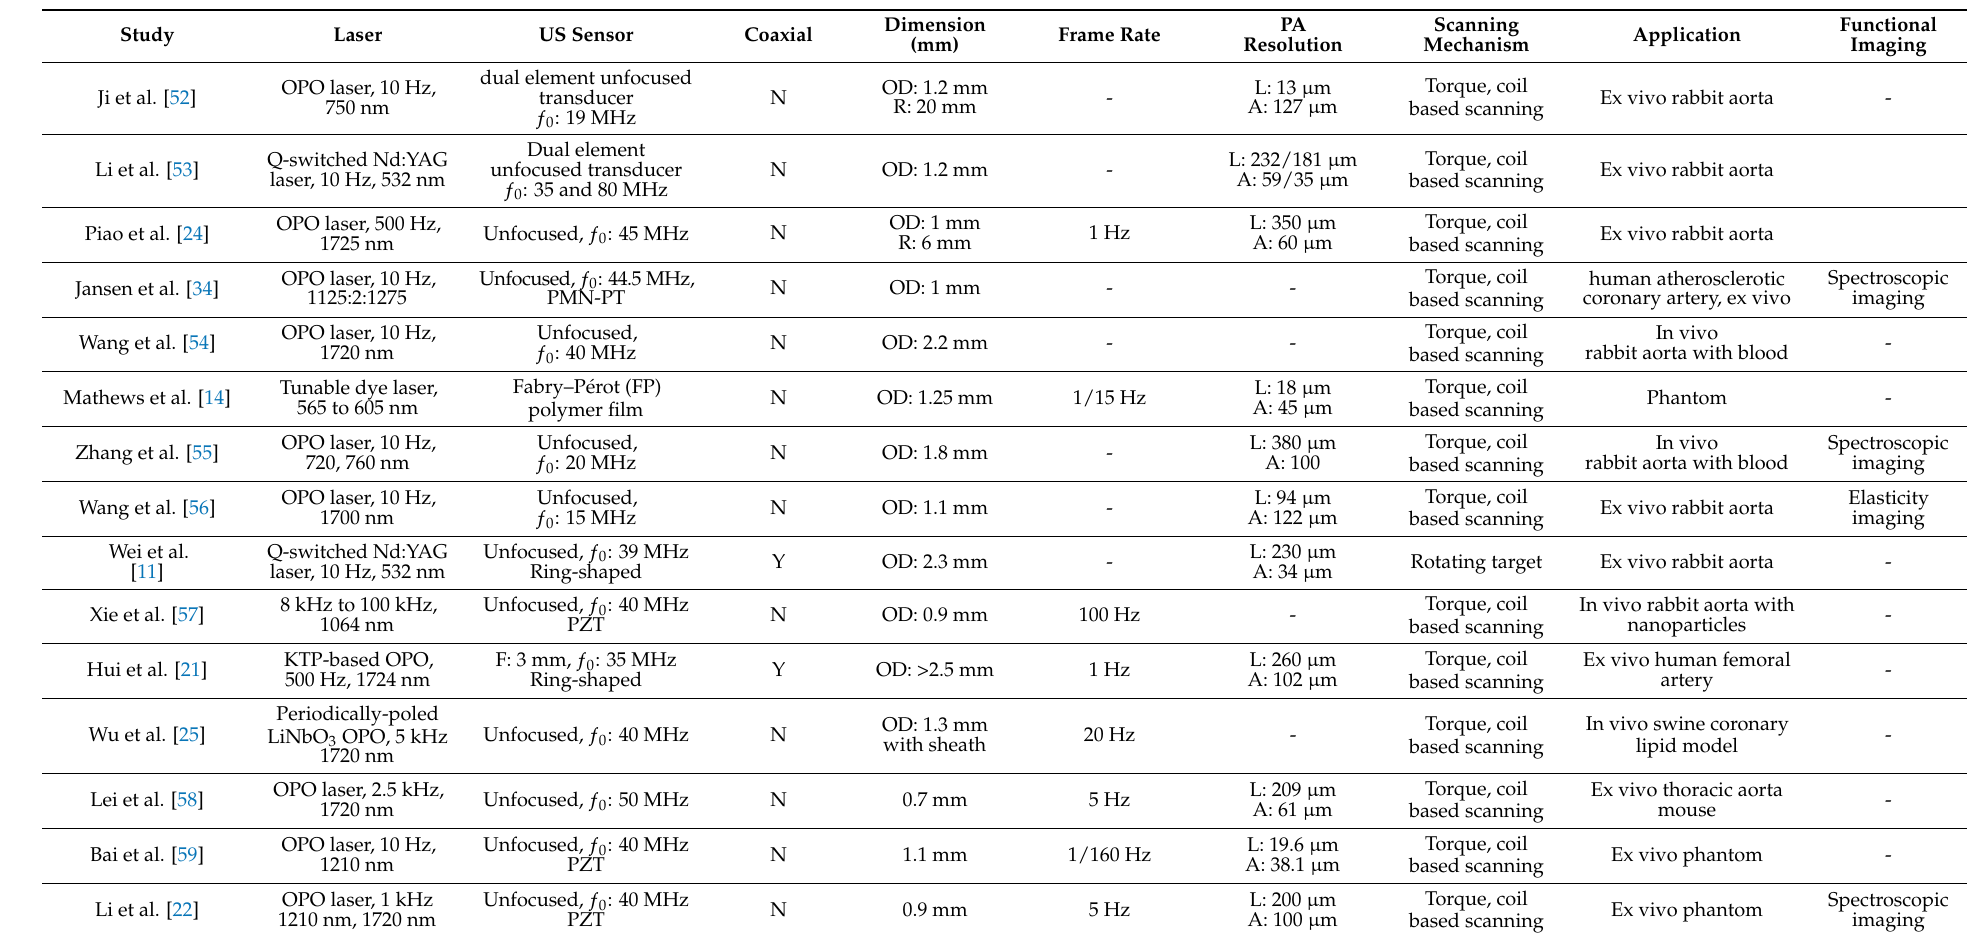
Table 3. Representative intravascular photoacoustic imaging